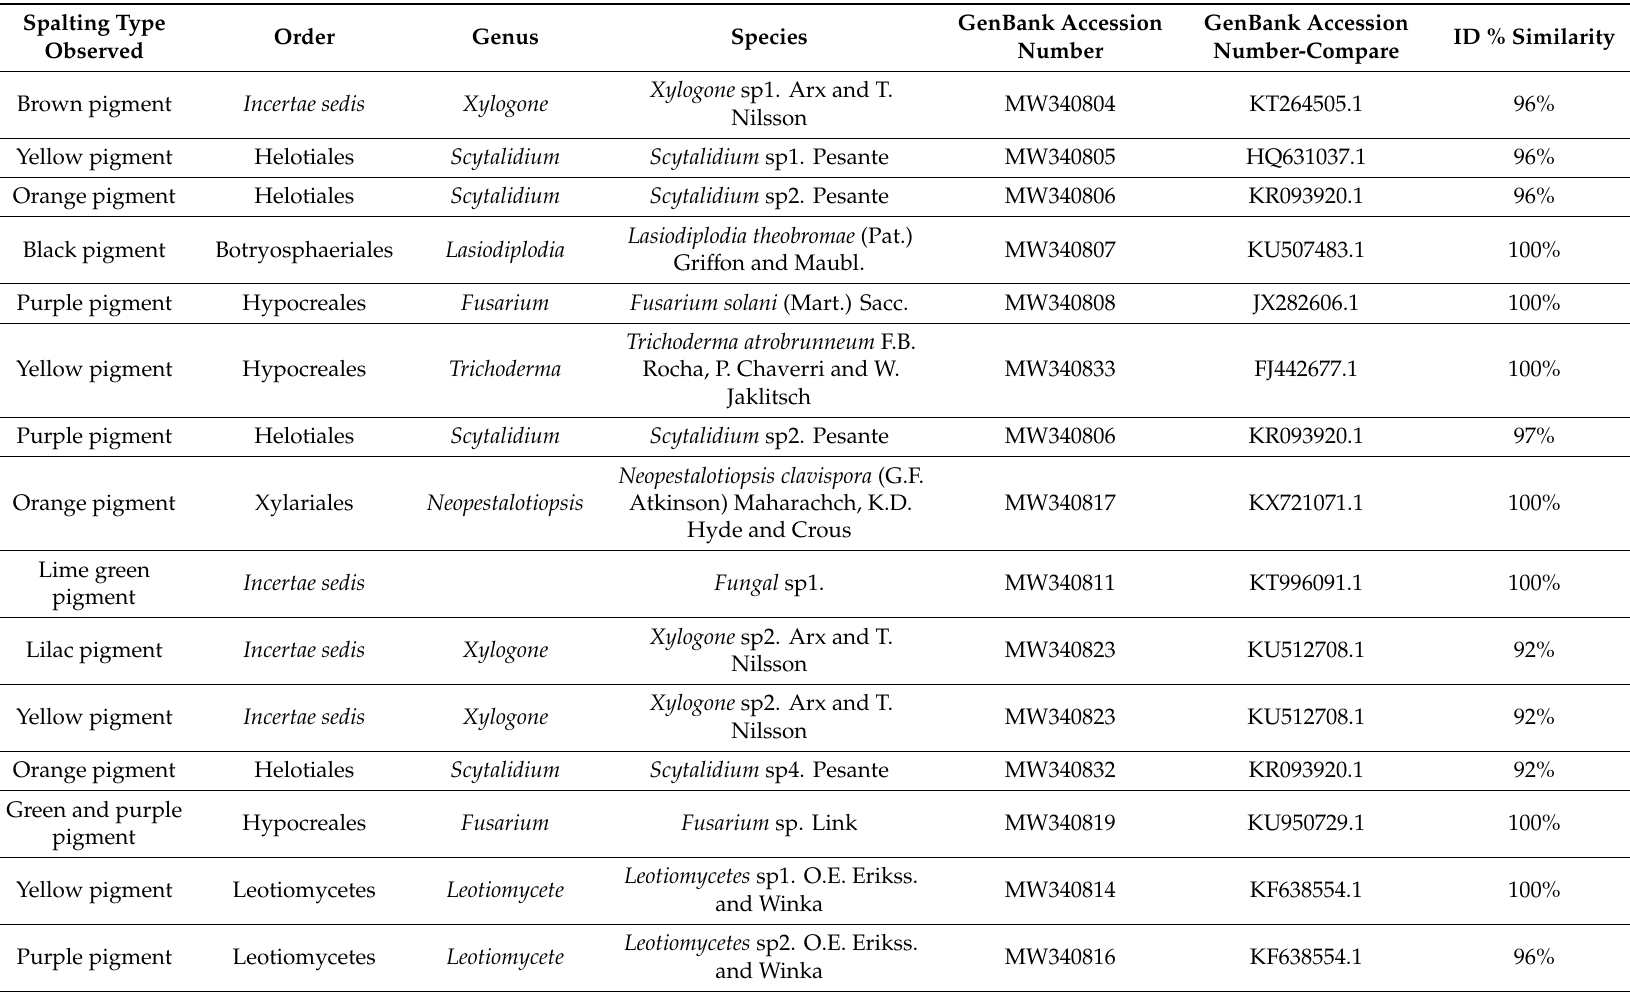
Table 1. Fungi identified from the Peruvian Amazon rainforest from the region of Madre de Dios. As all these fungi were pulled from spalted wood, they are assumed to be, at least preliminarily, capable of some degree of